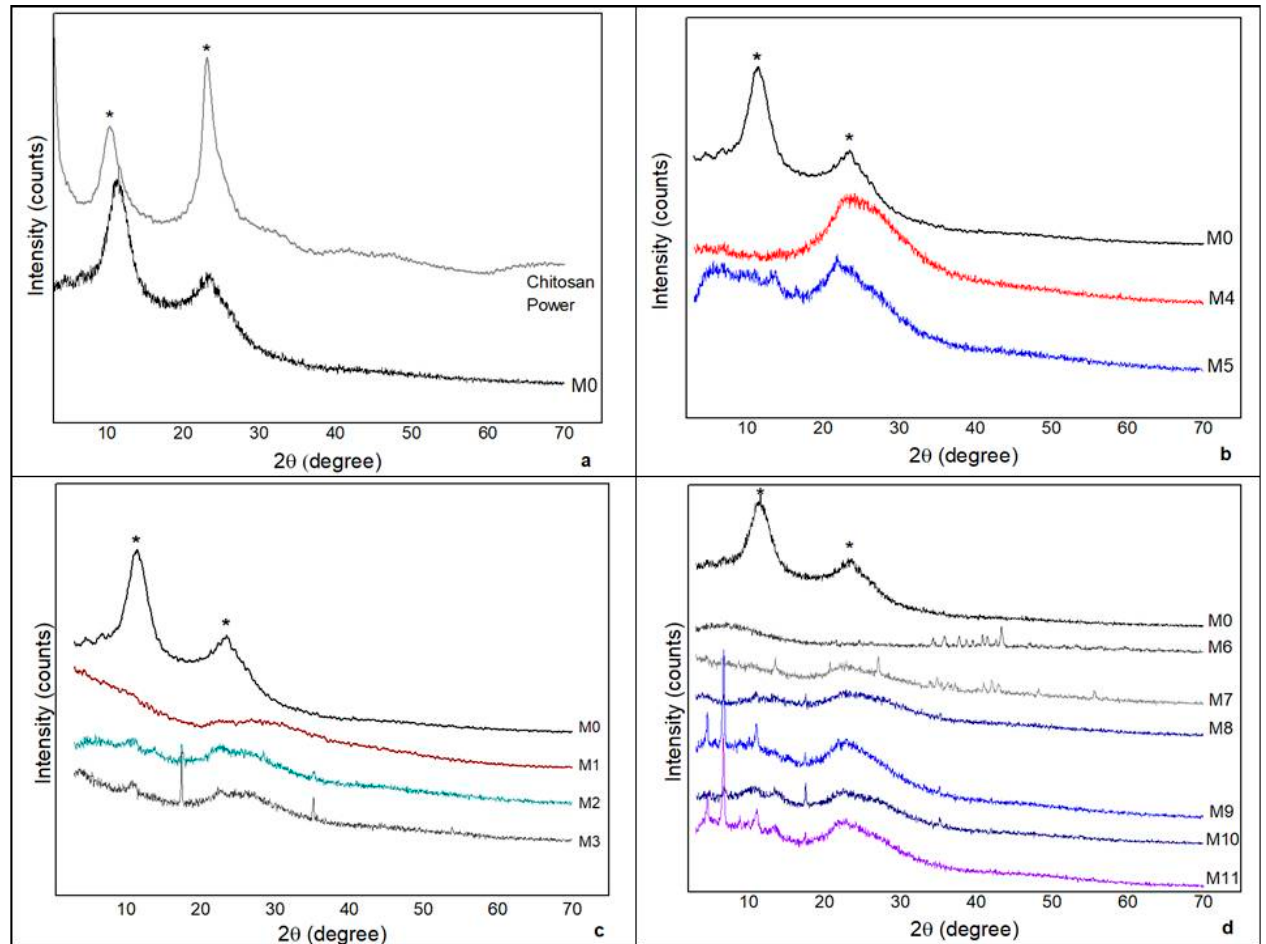
Figure 9. X-ray diffractogram. ( a ) Chitosan powder and pure chitosan membrane (M0). ( b ) M0 and chitosan membranes incorporated with andiroba oil (M4 and M5). ( c ) Chitosan membranes with green banana peel extract (M1, M2 and M3). ( d ) Chitosan membranes with green banana peel extract and/or andiroba oil. * Chitosan.